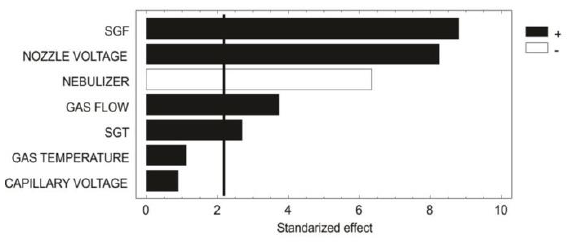
Figure 1. Pareto chart showing distinct factor effect patterns.